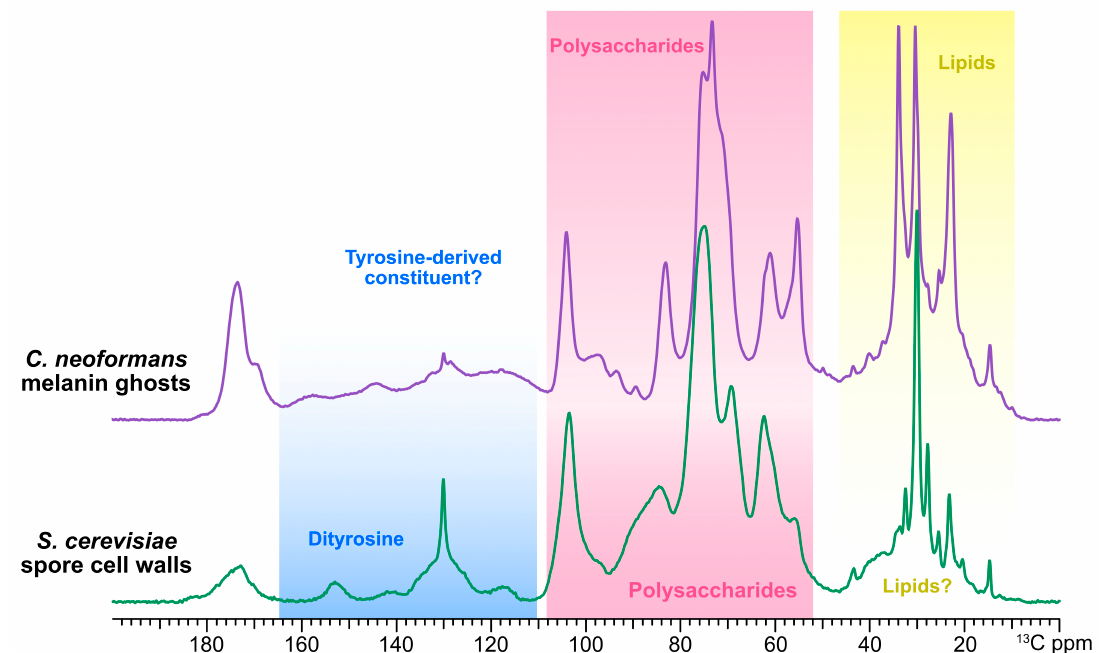
Figure 1. One-dimensional (1D) 13 C CPMAS solid-state NMR (ssNMR) spectral comparison of outer spore walls isolated from wild type (AN120) S. cerevisiae spore cell walls and melanin ghosts isolated from wild type (H99) C. neoformans cells. The cells from both species were grown in media containing [U- 13 C 6 ]-enriched glucose as the sole carbon source. C. neoformans cells were also provided natural abundance l -DOPA and thus signals attributable to the melanin pigment are not observed. The spectral region shaded in blue displays the peaks previously attributed to dityrosine carbons in S. cerevisiae spore cell walls, and the region in yellow to lipid carbons in C. neoformans melanin ghosts. The spectral region shaded pink displays peaks previously attributed to the carbons of the polysaccharides in each sample. The unshaded spectral region (165–185 ppm) displays several overlapping peaks that are attributed to the carbonyl carbons in all three constituent types.